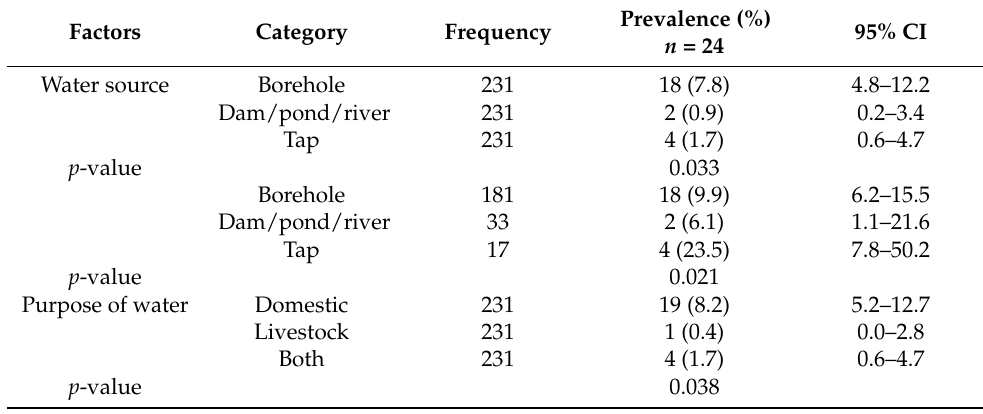
Table 3. Overall prevalence of NTM infection in